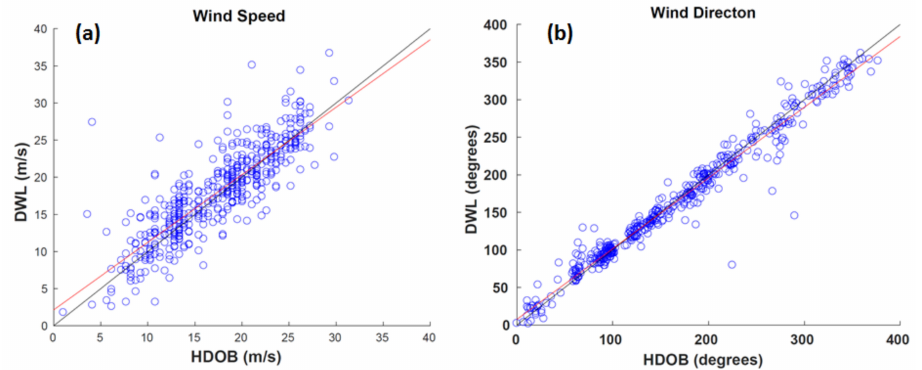
Figure 5. Comparison of collocated ADWL and high-density observation (HDOB) wind observations. ( a ) Wind speed (m s − 1 ) comparison shown with the line of best fit (red) and the line of perfect correlation (black); ( b ) Same as ( a ), but with wind directions